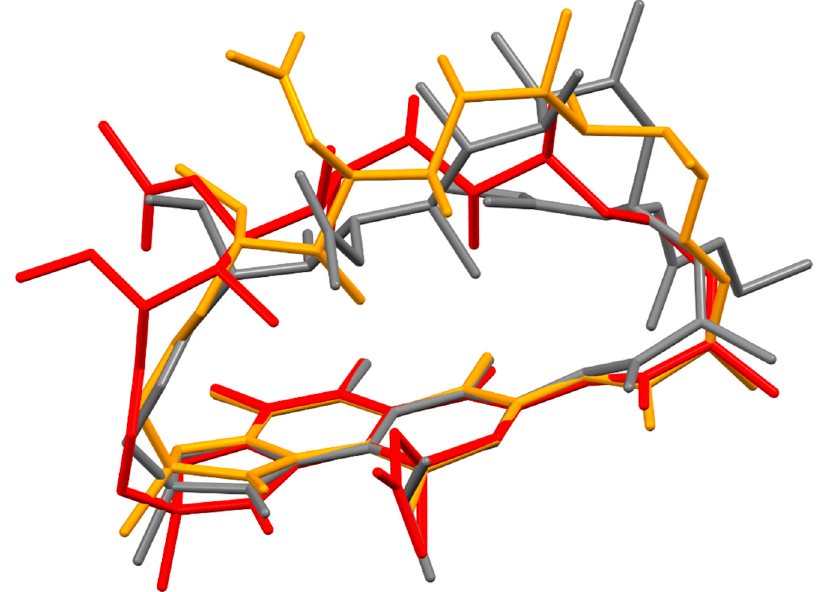
Figure 4. Overlay of compound 3 (grey), Rifamycin O (red) and Rifamycin S (orange) [active conformation]. See text for details.